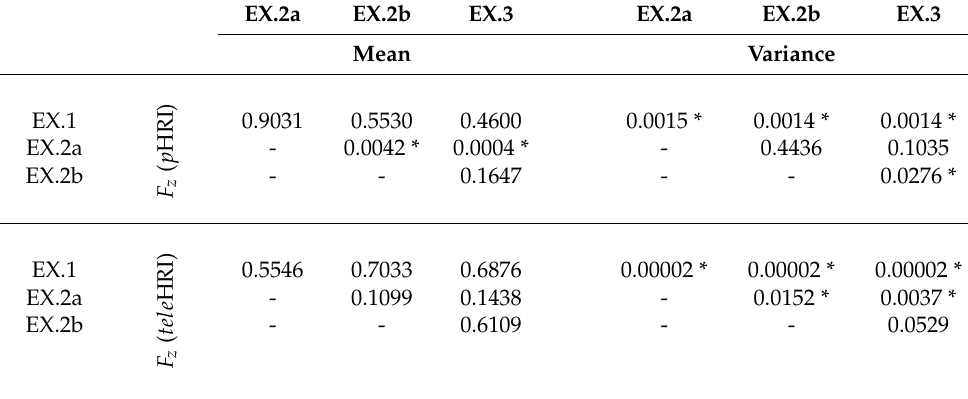
Table A6. Summary of p -values of t-test